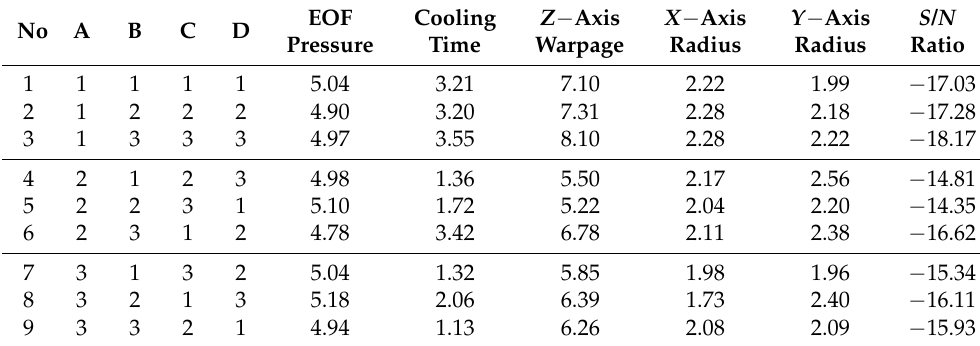
Table 14. Experimental results from the Taguchi orthogonal array.